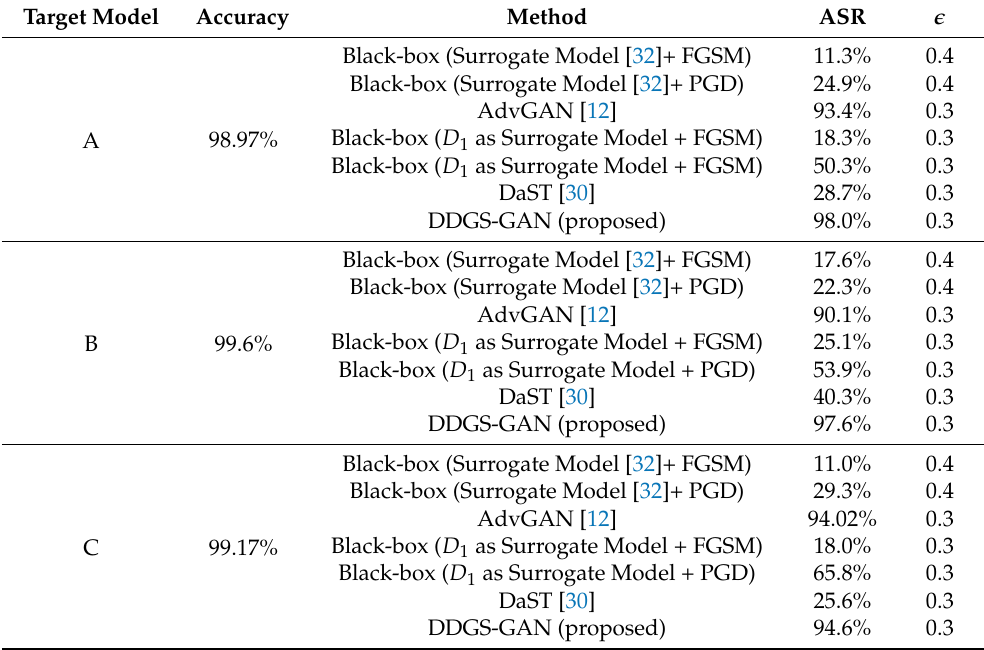
Table 5. Experimental results of targeted attack under l ∞